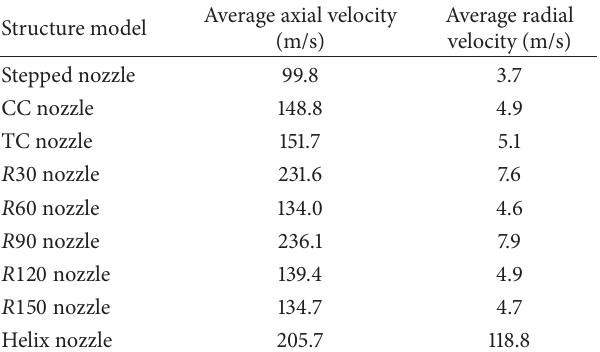
Table 3: Average axial and radial velocities of structure models in target distance range of 𝑋 = 0.08 ∼ 0.09 m.